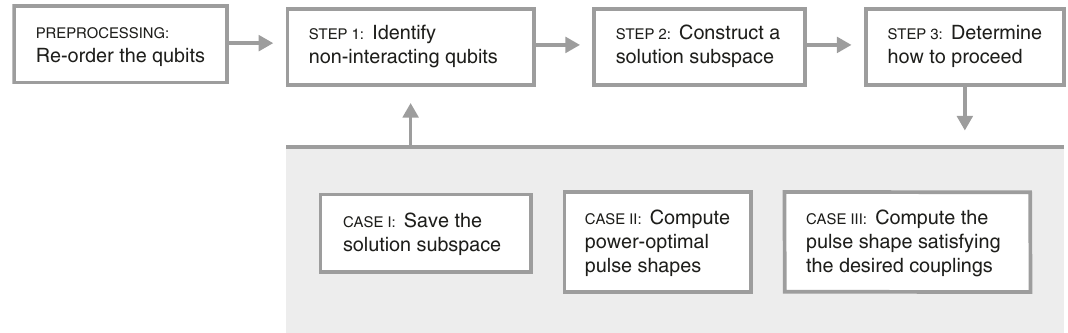
Fig. 2 Flowchart for EASE-gate pulse-shape synthesis. As a preprocessing step, reorder those qubits that participate in a given EASE gate into disjoint, non-interacting sets, where the fi rst and second qubits of each set interact. In other words, within each set, overlapping qubit pairs may interact, if the size of the set is larger than two. Consider now the following iterative steps. In Step 1, identify the qubits considered in the past iterations that do not interact with the currently considered qubit. In Step 2, construct a subspace orthogonal to the interactions between previously determined pulse shapes for